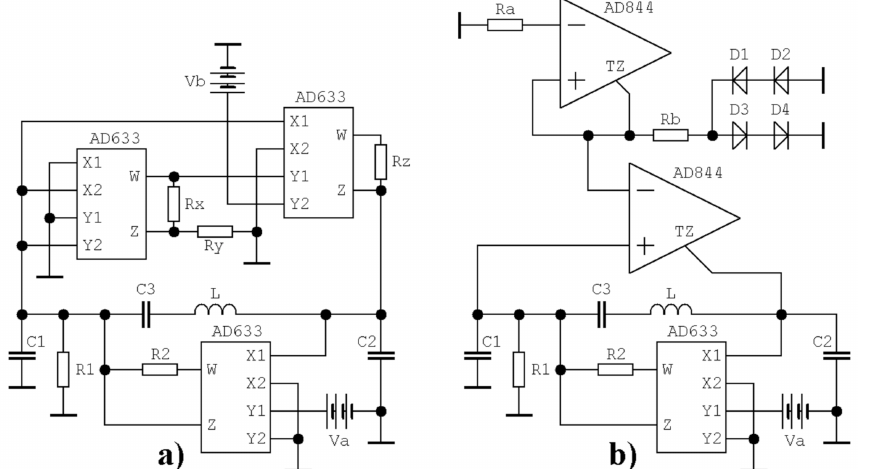
Figure 9. Circuitry implementation of chaotic Clapp oscillator: ( a ) Case I and ( b ) Case